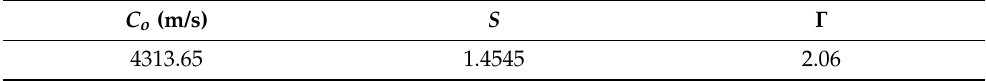
Table 4. Mie-Gruneisen equation of state parameters for X12Cr steel